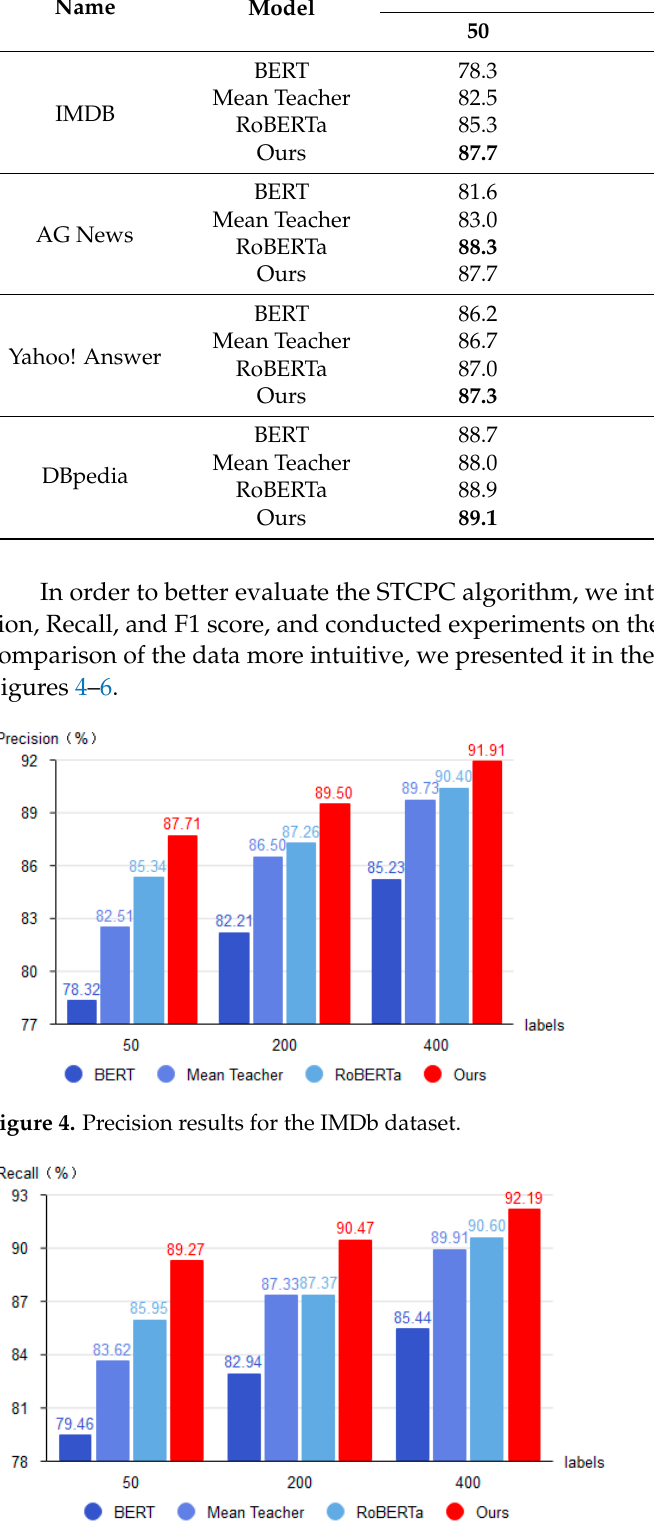
Figure 5. Recall results for the IMDb dataset.